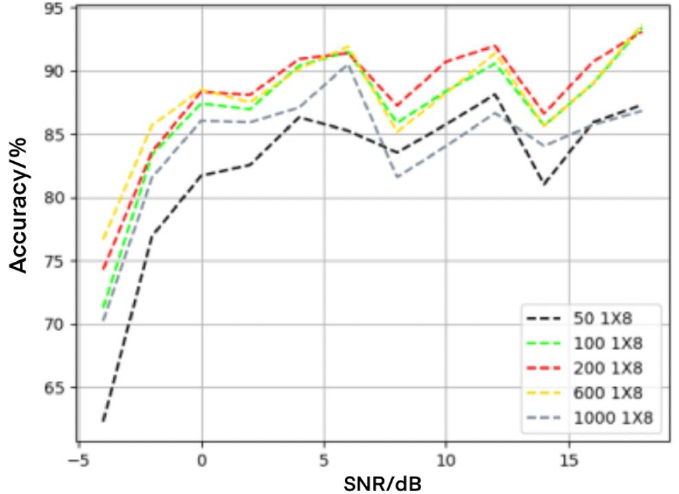
Figure 6. Effect of different convolution kernels on recognition rate (size 1 ×